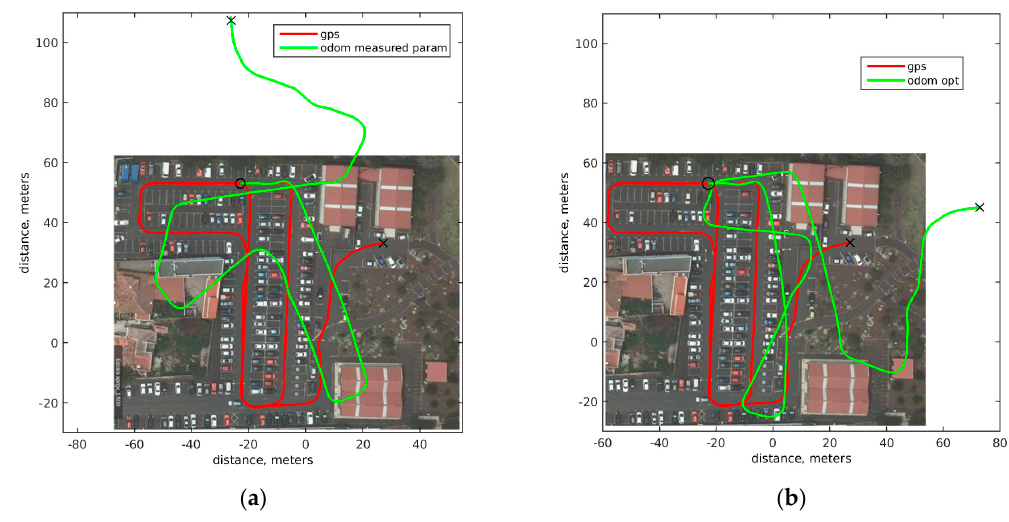
Figure 4. Optimization model results, solid red ground truth based in GPS. ( a ) solid green measurement parameters; ( b ) solid green optimization results.